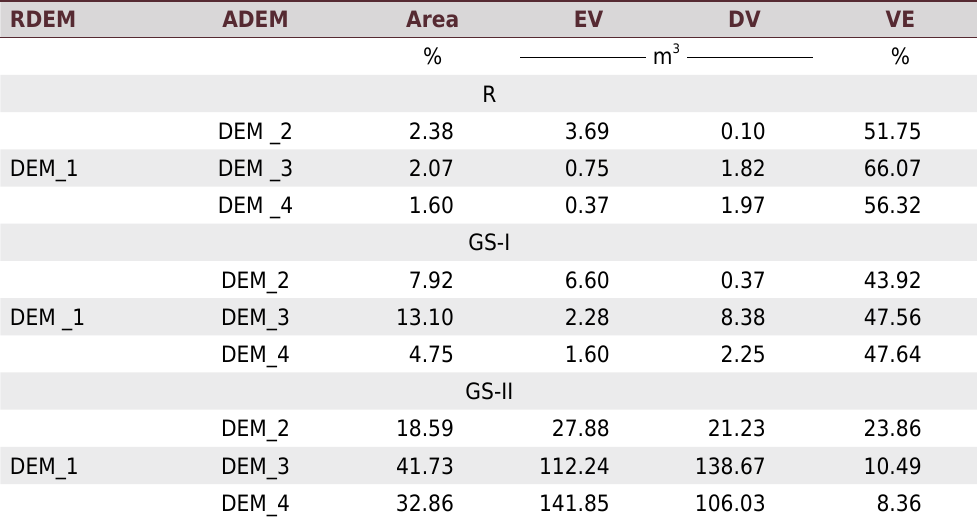
Table 6. Geomorphic Change Detection analyses for the rill erosion (R), small gully erosion (GS-I) and large gully erosion (GS-II) RDEM ADEM